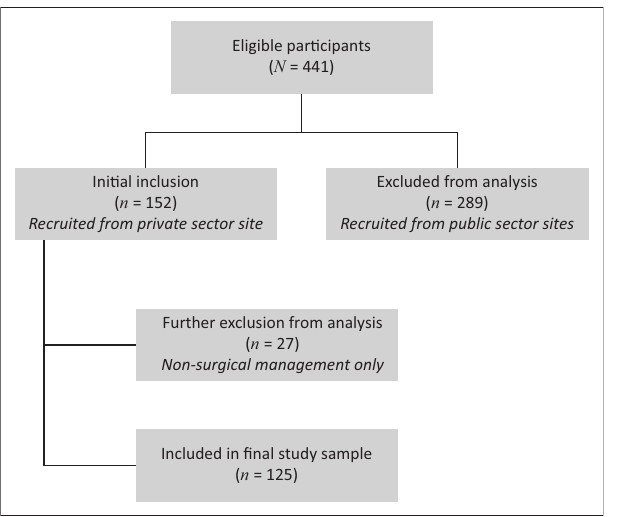
FIGURE 1: Flow chart of participant enrolment.